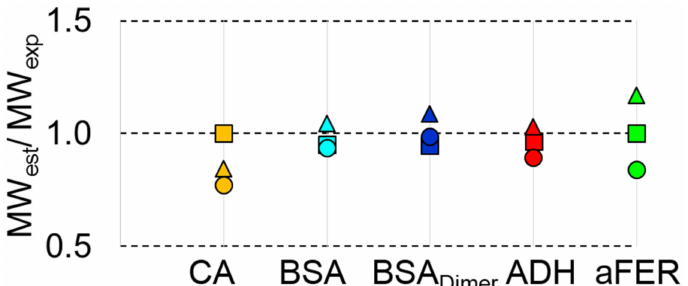
Figure 5. A comparison of the experimentally determined MW estimates from MALLS and SAXS in terms of the ratio with the expected / calculated MW of each protein. Depicted are the ratios of MW MALL S (squares), MW Bayesian (circles), as well as MW I(0) (calibrated with scattering of BSA as standard; triangles) over MW exp , taking into account the oligomerization state of each protein